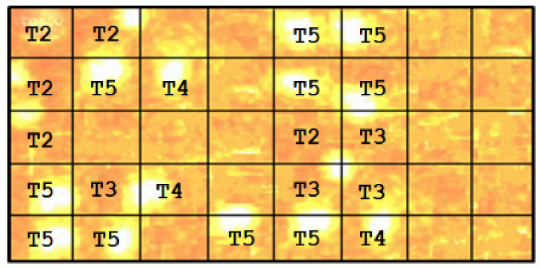
Figure 9. Temperature map.